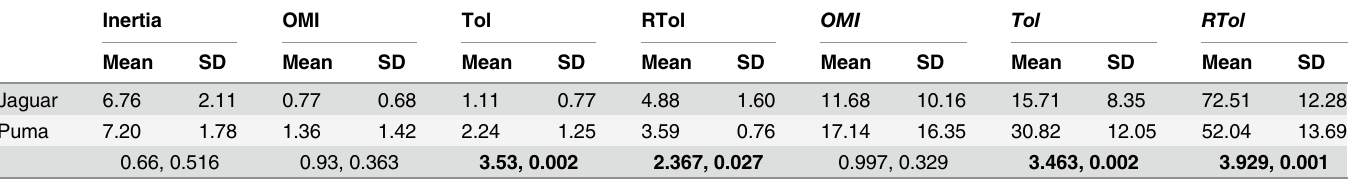
Table 2. Mean values of niche parameters for jaguars and pumas. Inertia